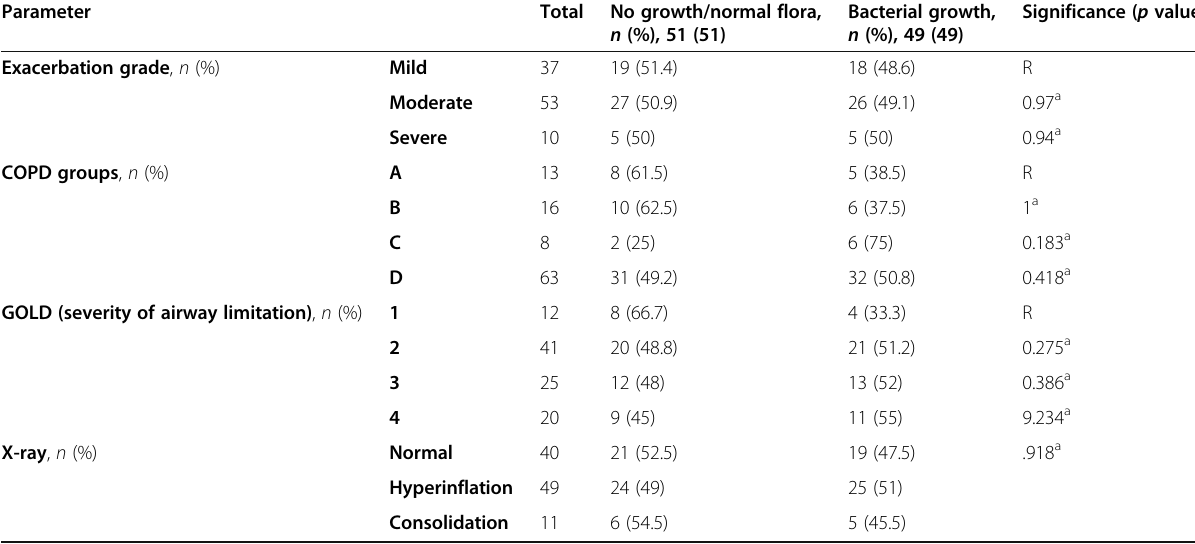
Bacterial growth, Significance ( p n (%), 51 (51) n (%), 49 (49)